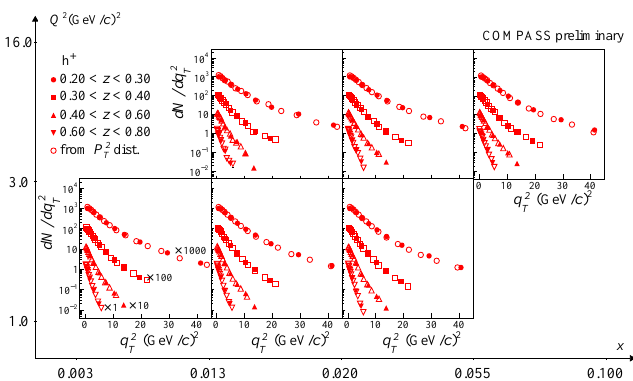
Figure 4: q 2 —distributions for positive hadrons in four z bins and in bins of x and T Q 2 , as obtained with a direct extraction (full markers) and (open markers) from a conversion of the P 2 -distributions in Fig. T